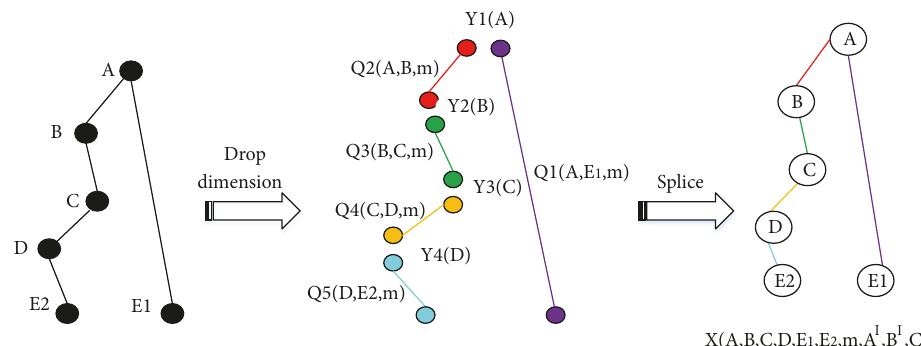
Figure 2: Collaborative dimension